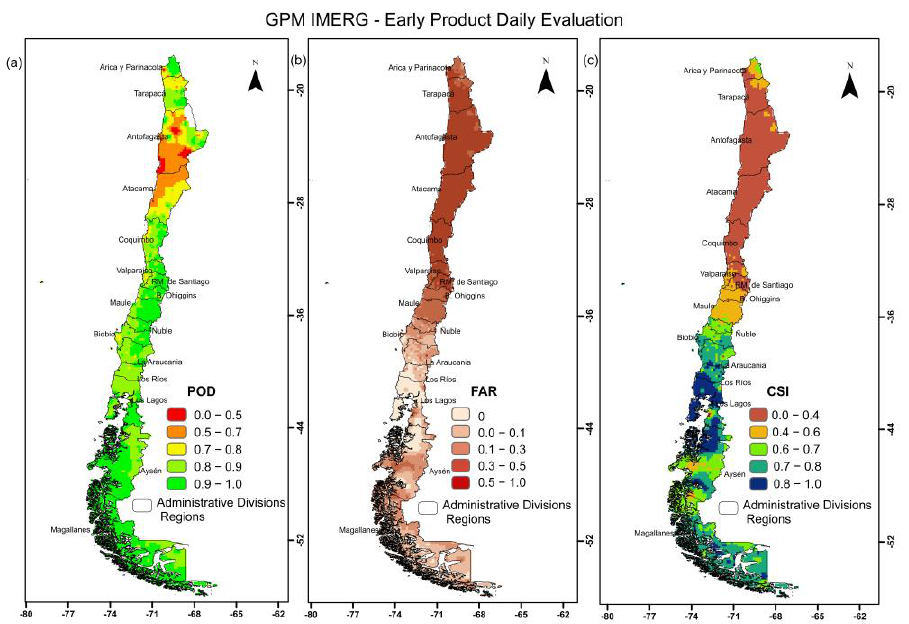
Figure 3. Satellite detection accuracy based on ( a ) POD, ( b ) FAR, and ( c ) CSI.